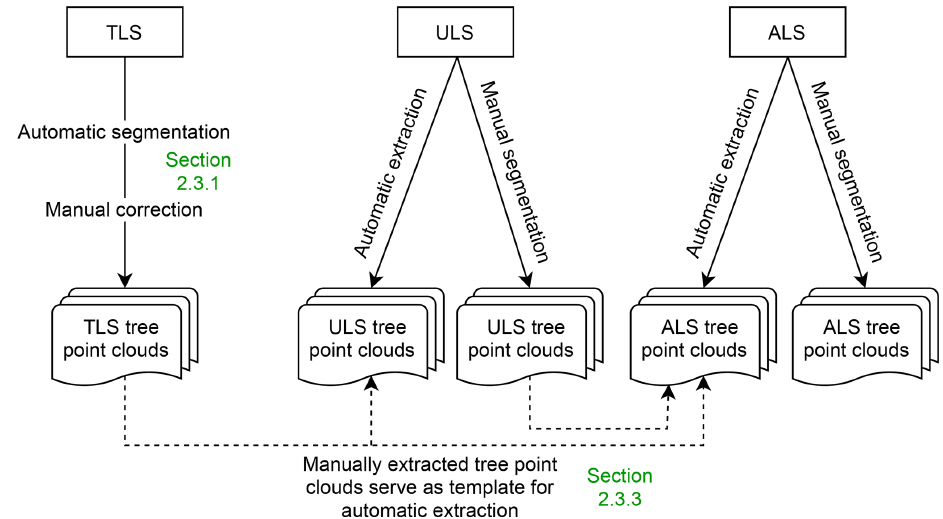
Figure 5. The different ways of single tree extraction. TLS point clouds were extracted with a combination of automatic segmentation and manual correction. ULS and ALS point clouds were partly segmented manually and partly extracted using a higher-resolution point cloud from another platform (i.e., TLS and